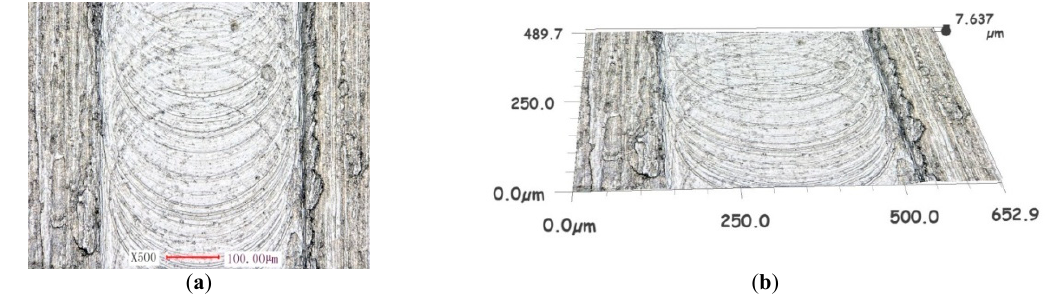
Figure 13. The micro groove surface topography for Ti-6Al-4V without run out. ( a ) Surface of micro groove. ( b ) Topography of micro groove.